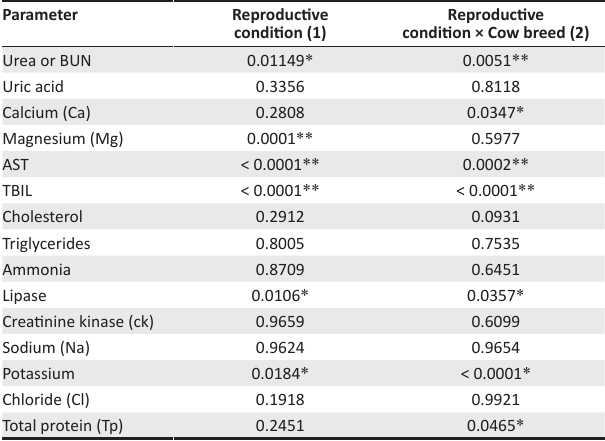
TABLE 1: p -Values obtained after statistical analysis of variance between average serum metabolites concentrations in cows affected by reproductive condition without the breed distinctions and within different